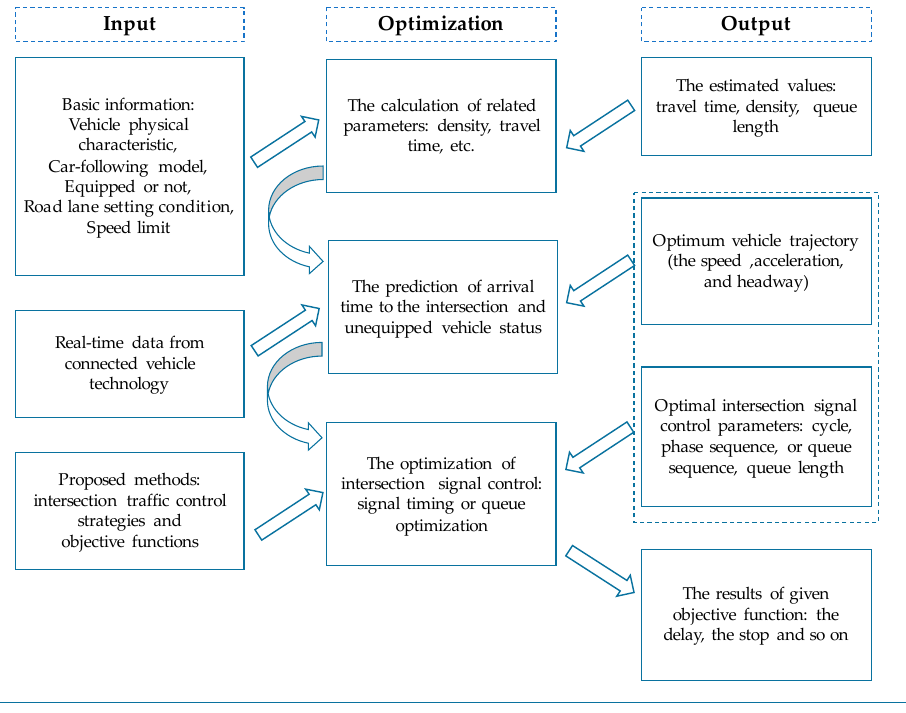
Figure 2. The framework of adaptive traffic signal control in a connected vehicle environment.